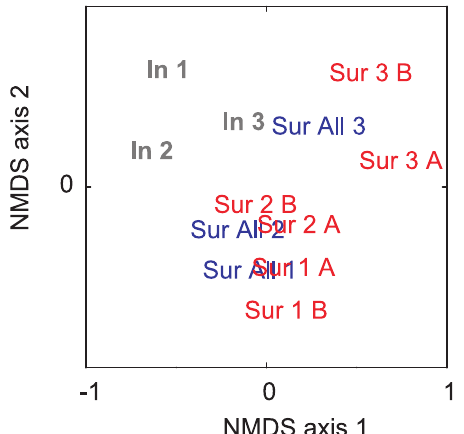
Fig 7. NMDS ordination of Spillway West samples. Non-metric multidimensional scaling (NMDS) ordination of the three Spillway West samples separated into in-place (In), 100% surface sample (Sur All), and the two 25% surface subsamples (A and B). The lower the number, the lower stratigraphic